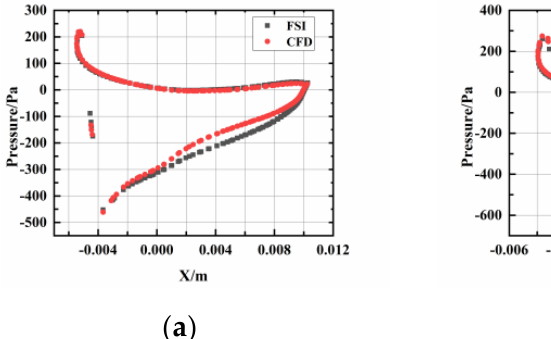
Figure 6. Graph of C p with TSR.